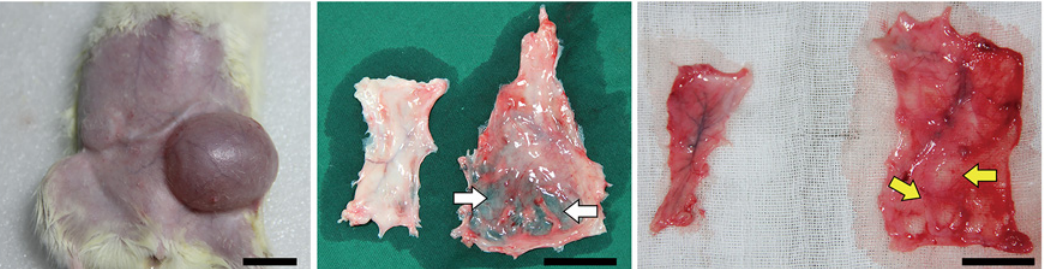
Fig 1. Rat fat pad expantion. Left: Rats after transplantation of the expander. Middle: The expanded fat pad became thinner (white arrows). Right: After removal of the expander, the regrowth of adipose-liked tissue (yellow arrows) was seen. Scale bar = 2 cm.